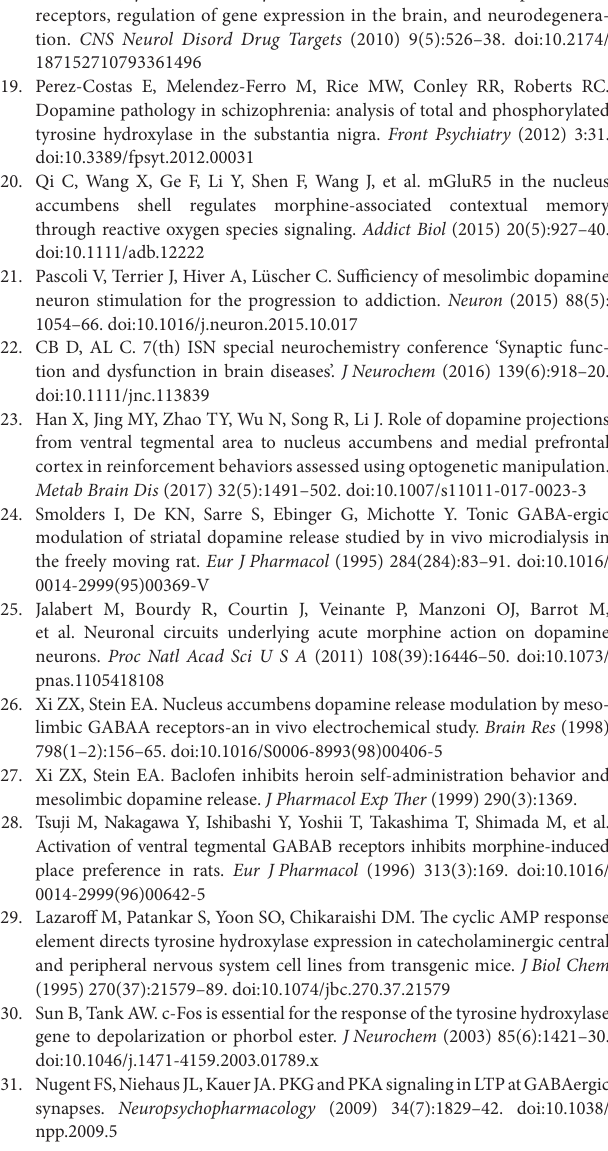
FigUre s1 | The expression of humanTrx-1 in the VTA and